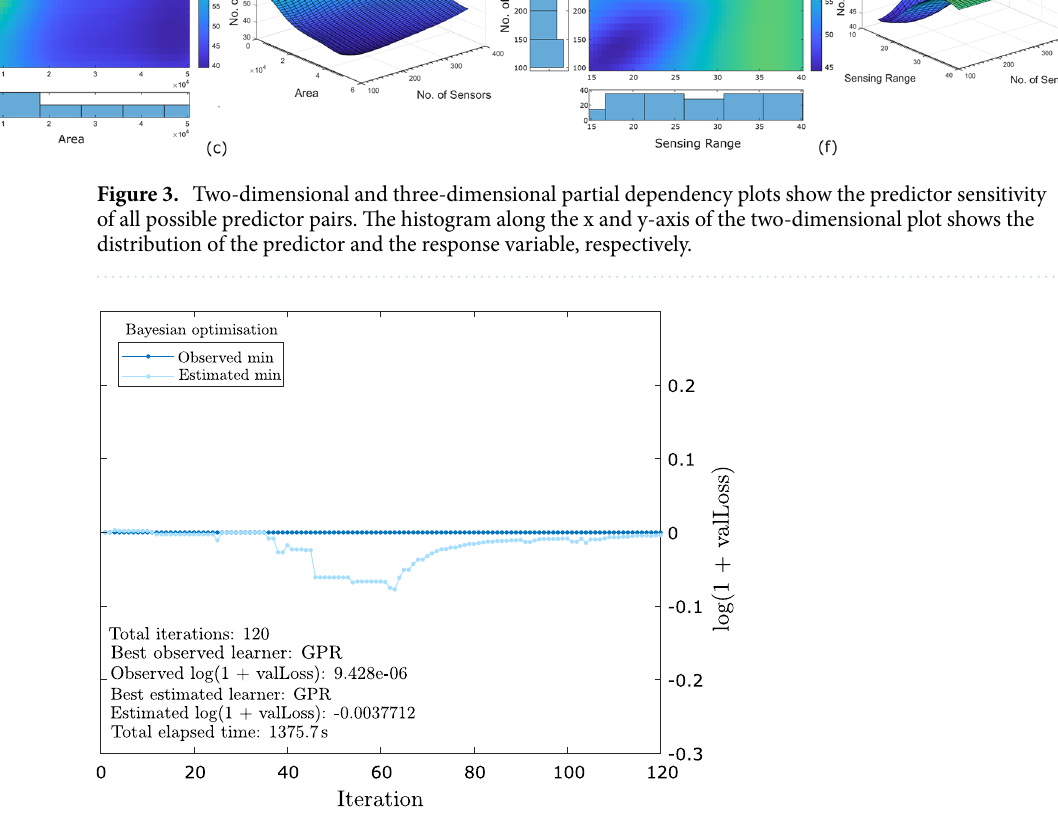
Figure 4. Curve illustrating the Bayesian optimisation process for the selection of the best machine learning model with optimal